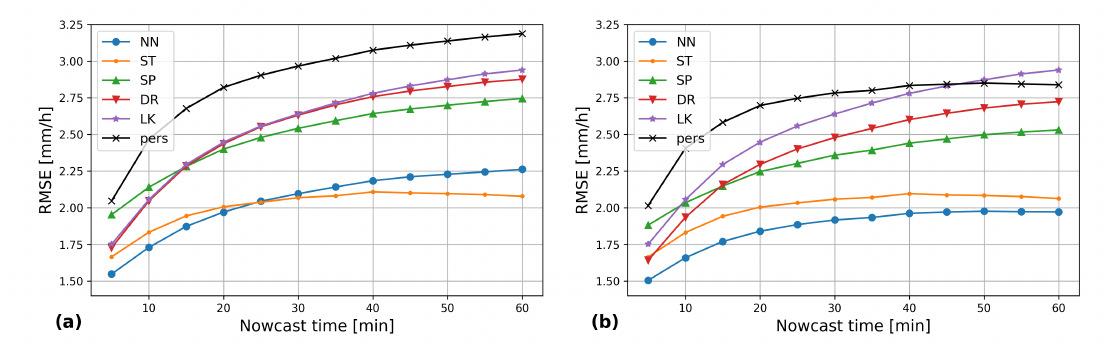
Figure 6. Average RMSE as function of the forecast time from 1’ to 60’, for all nowcast methods and persistence (2017). In box ( a ) the indicators are evaluated in the DS domain , in ( b ) the same indicators are calculated in